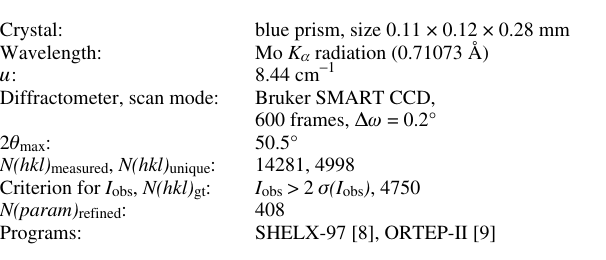
Table 1. Data collection and